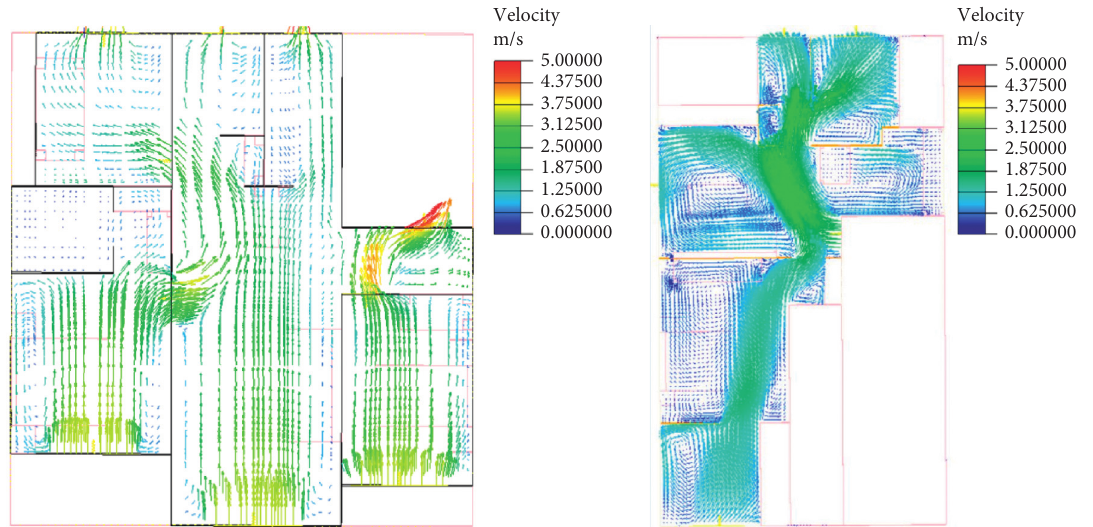
Figure 9: Velocity vector distribution of two house types A and B under condition